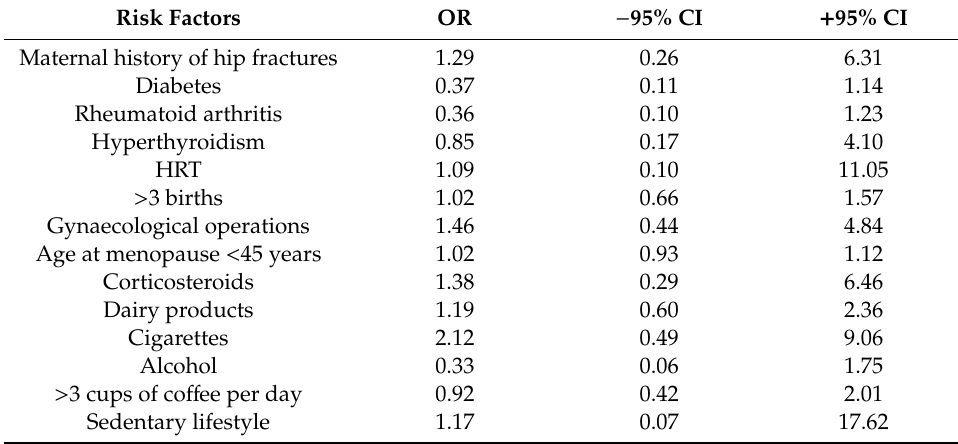
Table 3. Odds ratios for osteoporosis risk factors calculated from logistic regression